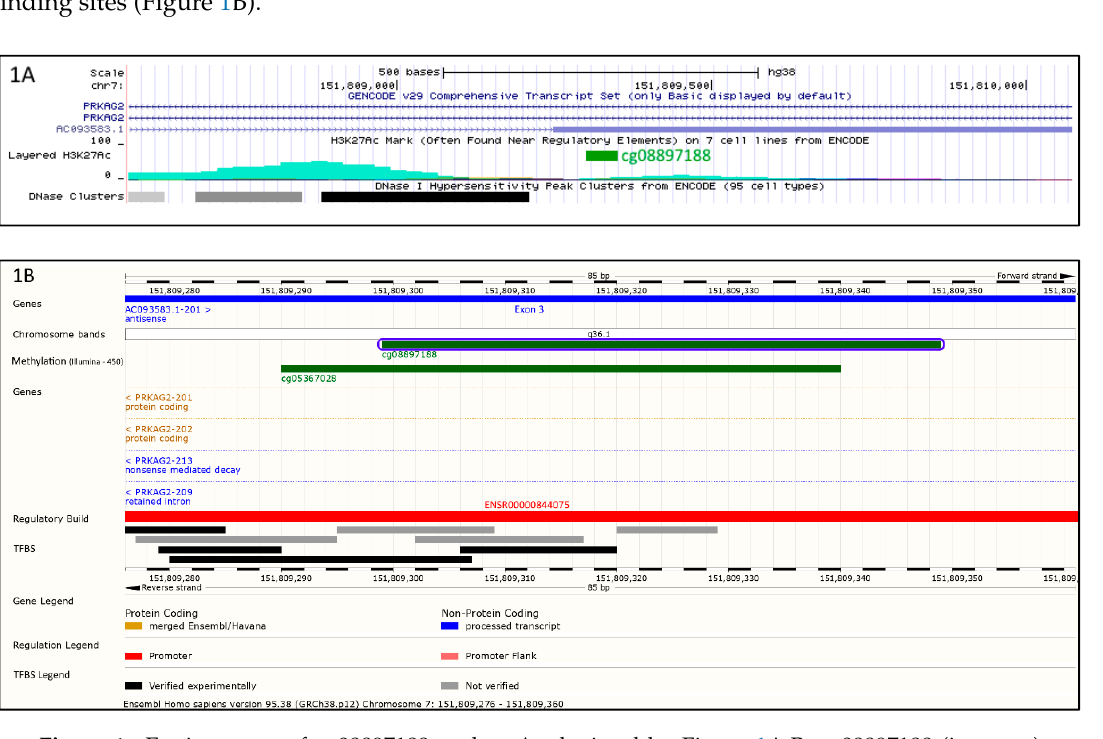
Figure 1. Environment of cg08897188 probe. As depicted by figures 1A and 1B, cg08897188 (in green) is located on chromosome 7q36.1 within intron of PRKAG2 gene of the forward strand and within exon 3 of the AC093583.1 non-coding transcript in the opposite strand. ( A ) shows that cg08897188 is surrounded by regulatory elements indicated by acetylation of histone 3 on lysine 27 (H3K27Ac peaks, in turquoise). Moreover, as indicated by DNase I hypersensitivity peak clusters (black and grey rectangles), this region has also an accessible chromatin zone, indicating a transcriptional activity. ( B ) confirms that cg08897188 is located within a regulatory zone (promoter ENSR00000844075, in red) with clearly identified transcription factor binding sites (black and grey